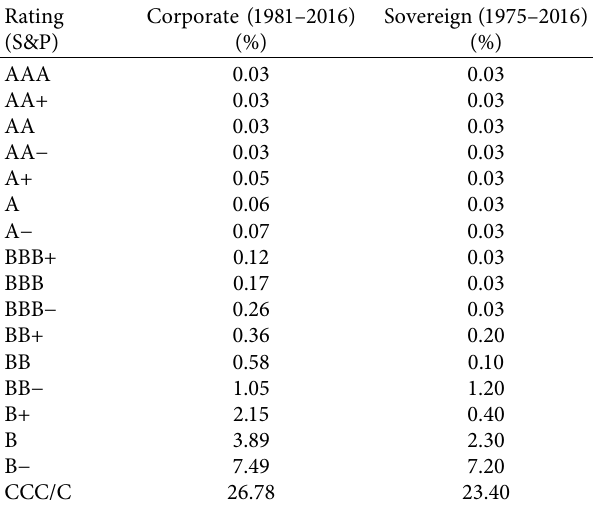
Table 1: Probability of default (PD) by